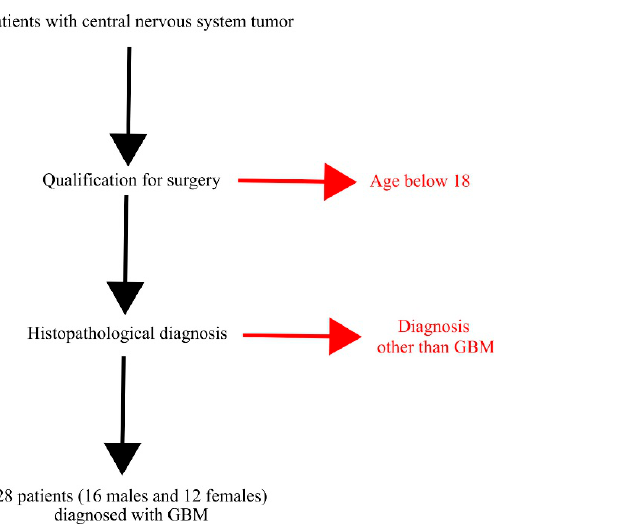
Figure 1. Inclusion and exclusion criteria for selecting and choosing patients from whom GBM tumor samples were analyzed.